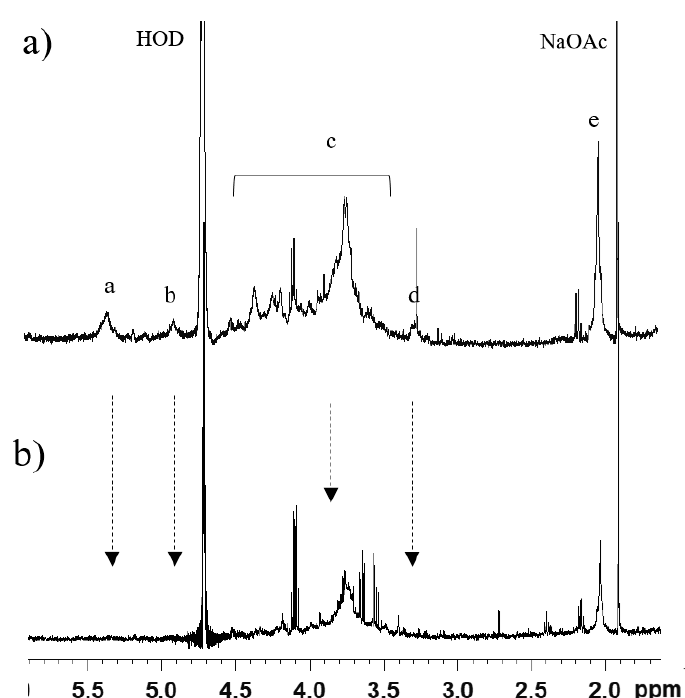
Figure 2. 1 H-NMR spectra of OC3-B ( a ) before and ( b ) after digestion with heparinases. Signals of heparan sulfate (HS) are indicated: a, H-1 of GlcNAc, N -sulfo- D -glucosamine (GlcNS), and 2- O -sulfo- L -iduronic acid (IdoA2S) (5.4 ppm); b, H-5 of IdoA (4.9–5 ppm); c, backbone signals; d, H-2 of GlcA and GlcNS (3.4 ppm); e, N -acetyl (CH 3 CO) of GlcNAc (2.0 ppm). Arrows indicate the decrease in